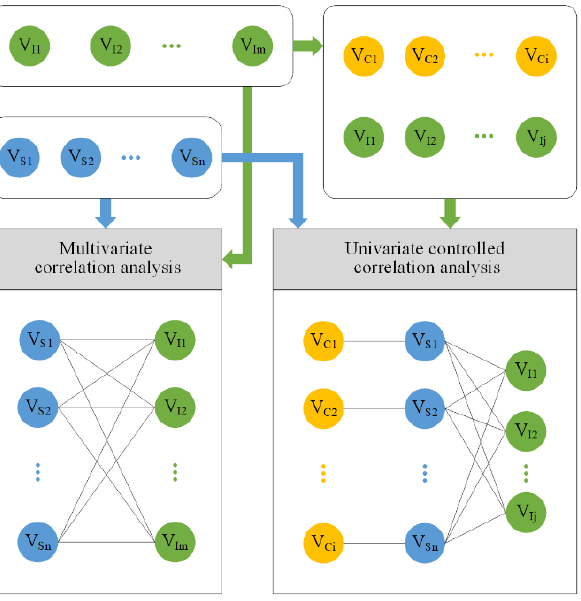
Figure 2. Model of correlation between ice conditions and ship movement characteristics.